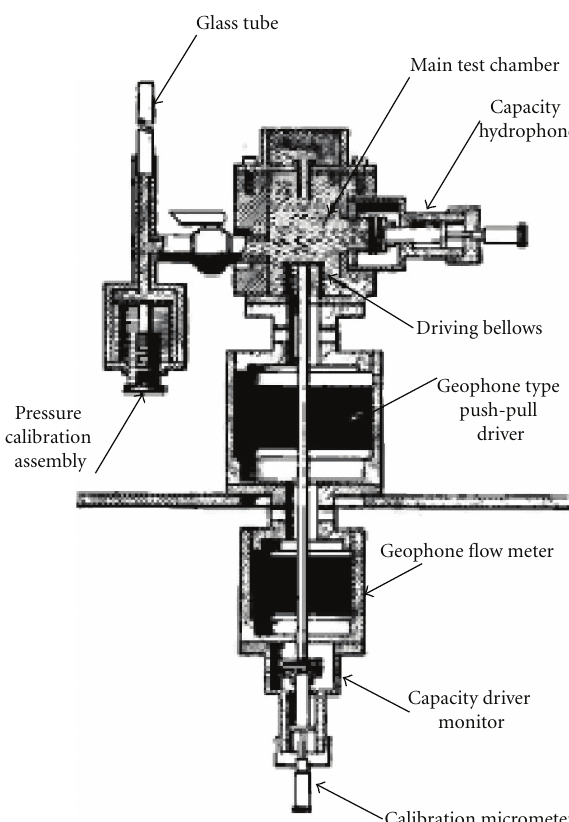
Figure 6: Experimental setup used by Reppert et al. [60] (modified from